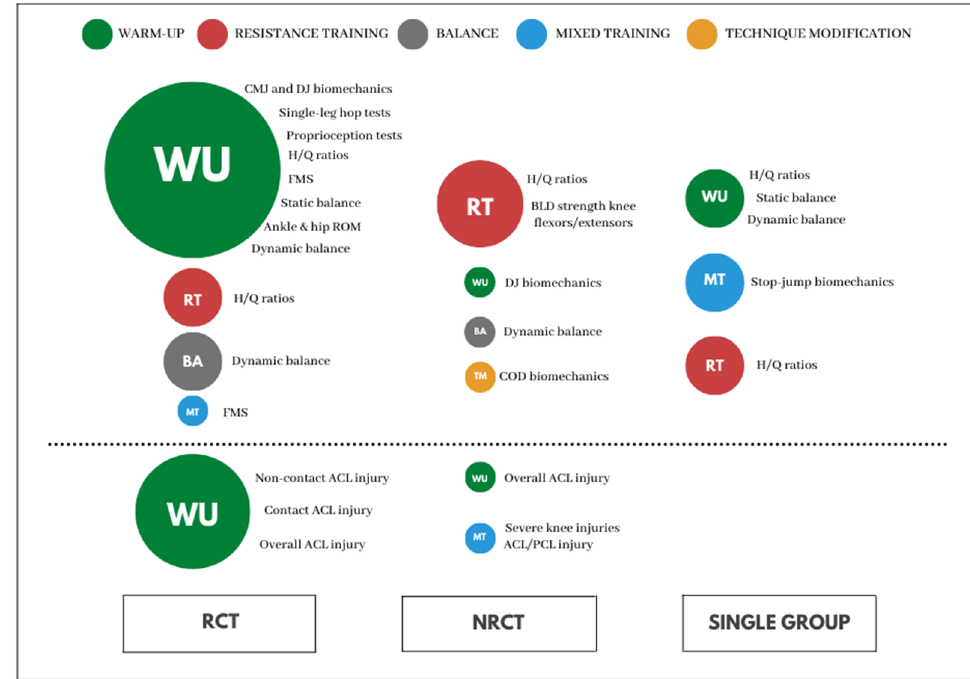
Figure 2. Representation of the different exercise-based interventions used to target both ACL injury risk mitigation (upper panel, over the dotted line) and ACL injury reduction (lower panel, under the dotted line), for each study design. The size of the circumferences represents the number of studies including the designated intervention (1 is the smallest, 6 is the biggest). To the right is the outcome measures used to evaluate their effectiveness. ACL—anterior cruciate ligament, BA—balance-based interventions, BLD—bilateral strength differences, CMJ—countermovement jump, COD—change of direction, DJ—drop jump, FMS—functional movement score, MT—mixed- training-based interventions, NRCT—non-randomised studies, PCL—posterior cruciate ligament, RCT—randomised-controlled trials, RT—resistance training-based interventions, TM—technique- modification-based interventions, WU—warm-up-based interventions.